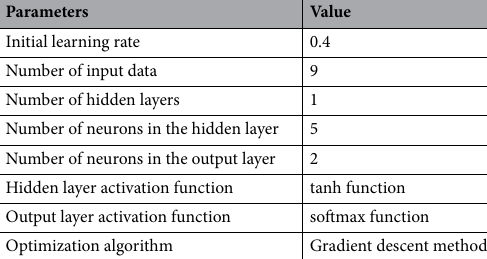
Table 2. Basic parameters of MLP